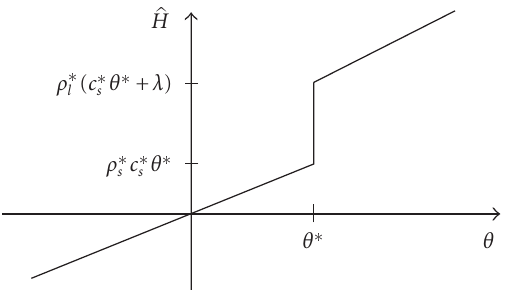
Figure 2.3. The graph of (cid:2) H ; θ ∗ is the melting